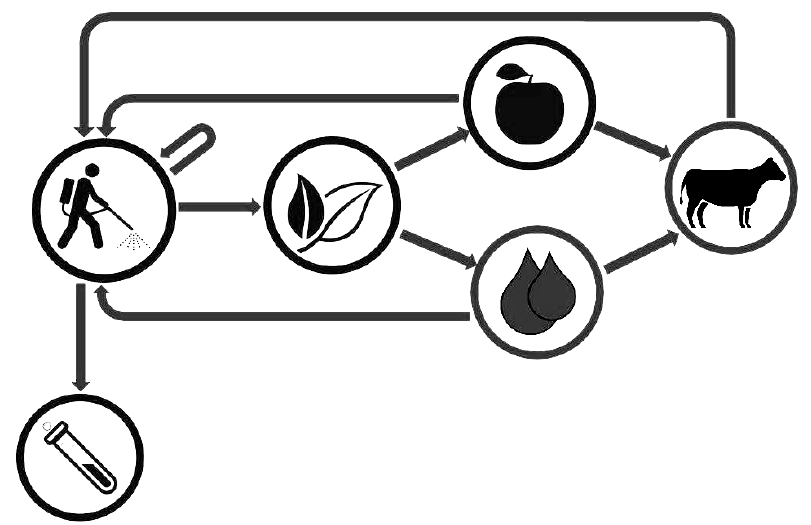
Figure 2. Sources of exposure to glyphosate [23,24].